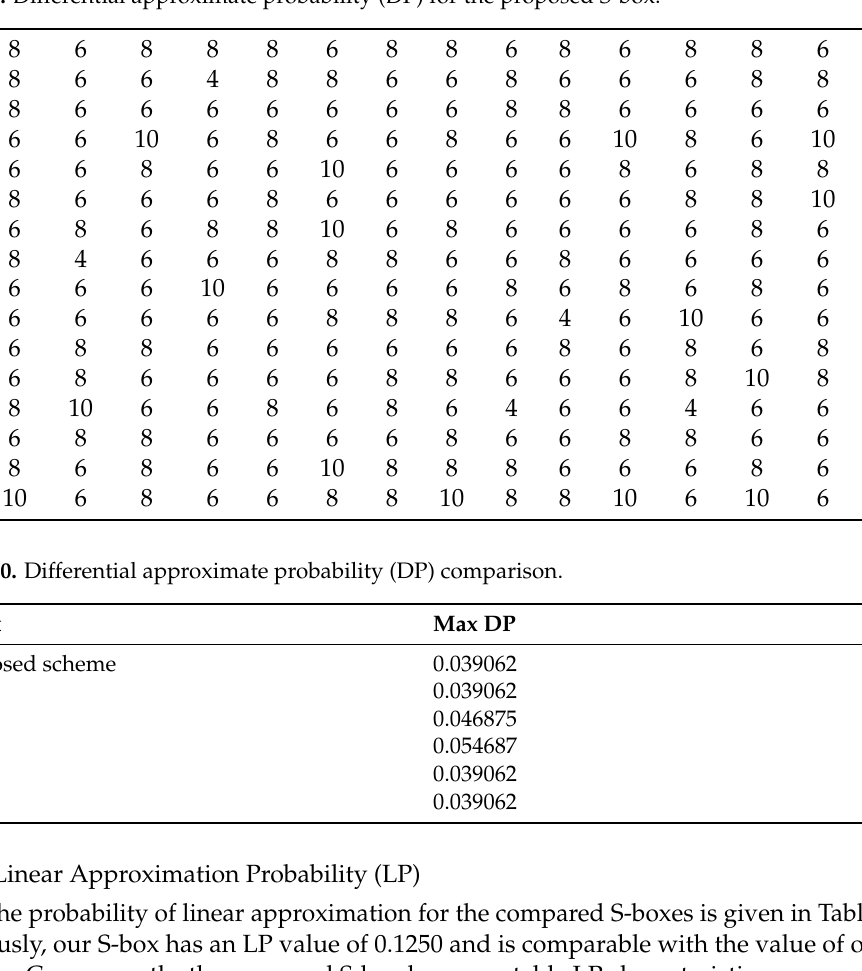
Table 9. Differential approximate probability (DP) for the proposed S-box.